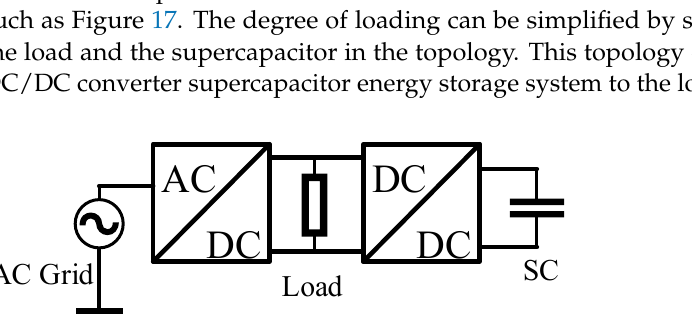
Figure 16. Schematic diagram of a two-stage converter system with supercapacitor and load.